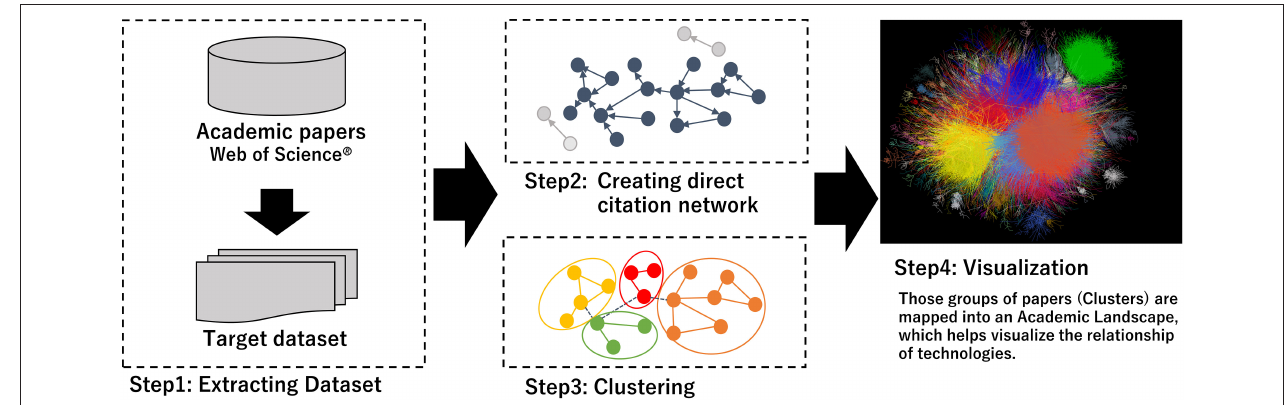
FIGURE 1 | Steps of clustering and making academic